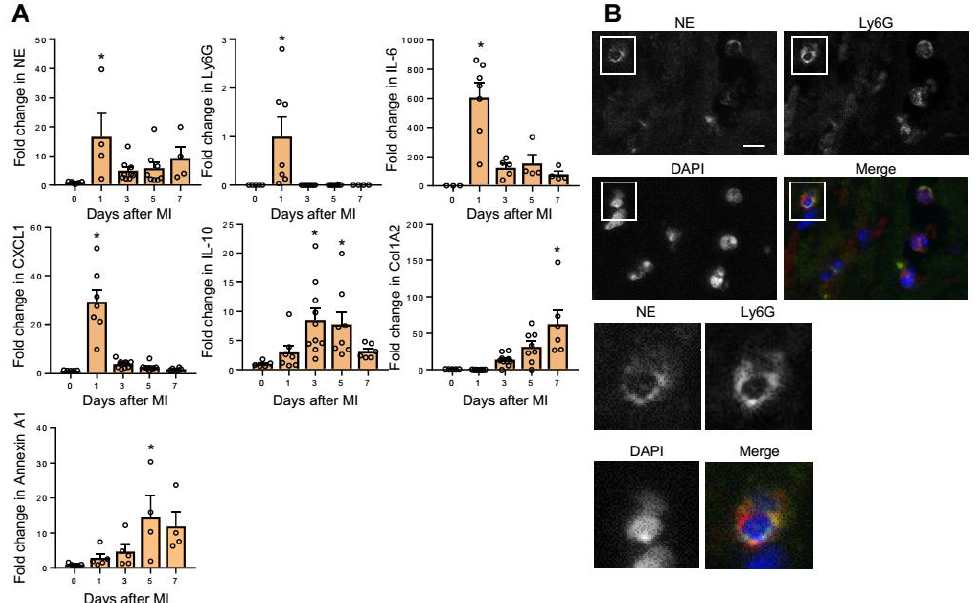
Figure 1. Neutrophil elastase (NE) expression peaked on day 1 post-myocardial infarction (MI) in infarcted hearts. ( A ) qRT-PCR analysis in hearts on day 0 (prior to the induction of MI) and on days 1, 3, 5, and 7 post-MI. Results are presented as mean ± SEM, n = 4–9 each, * p < 0.05 vs. day 0. ( B ) Representative immunofluorescence images of wild-type (WT) heart sections on day 1 post-MI. NE (yellow), Ly6G (red), and nuclei (blue). The lower panels show a higher magnification of the white boxes in the upper panels. Scale bar = 20 μm.